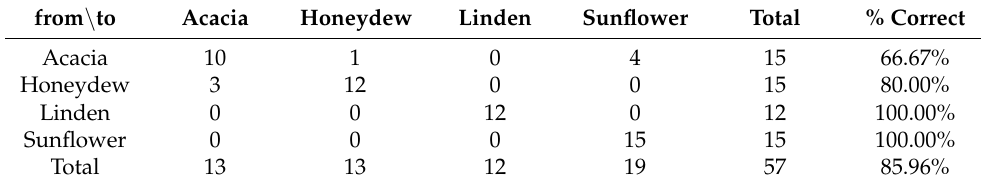
Figure 2. LDA map of kind of honey based on VOCs content. Table 3. Confusion matrix for the cross-validation